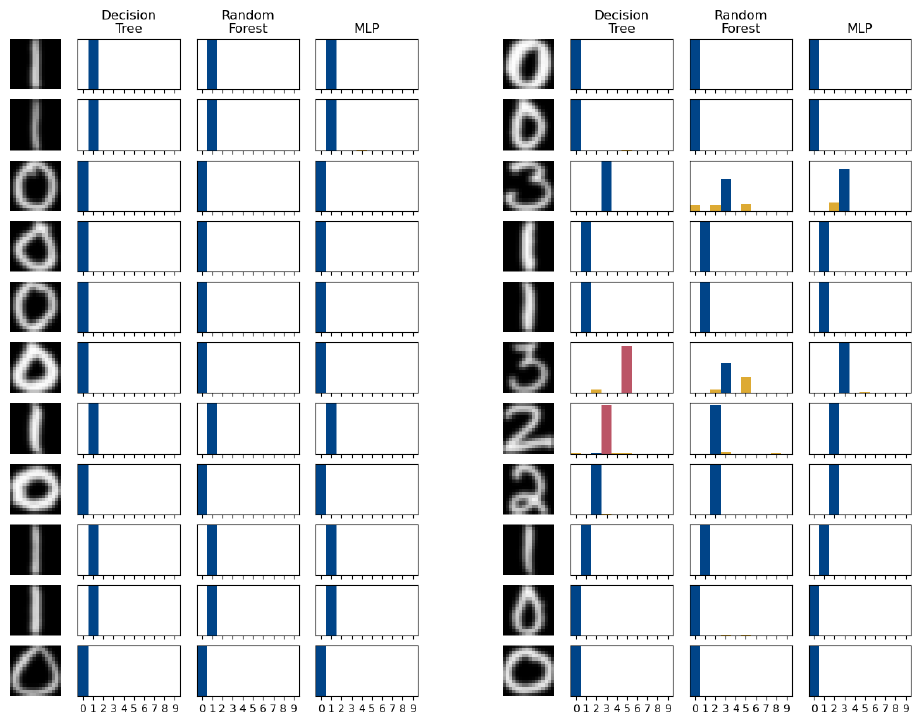
Figure 18. Exemplars over-represented in Q a , with class probabilities under three algorithms trained on X a . The true class is shown in blue ; where the highest probability class differs from the true class, the highest probability class is shown in red .